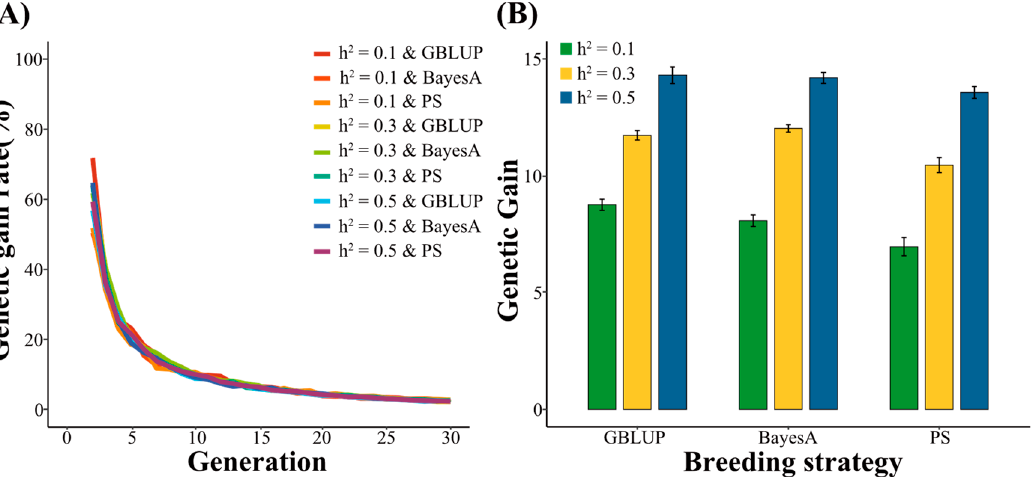
Figure 4. ( A ) Genetic gain rates across 30 generations for all scenarios using 100 K SNPs. ( B ) The genetic gains of the 30th generation based on 100 K SNPs for different heritabilities.